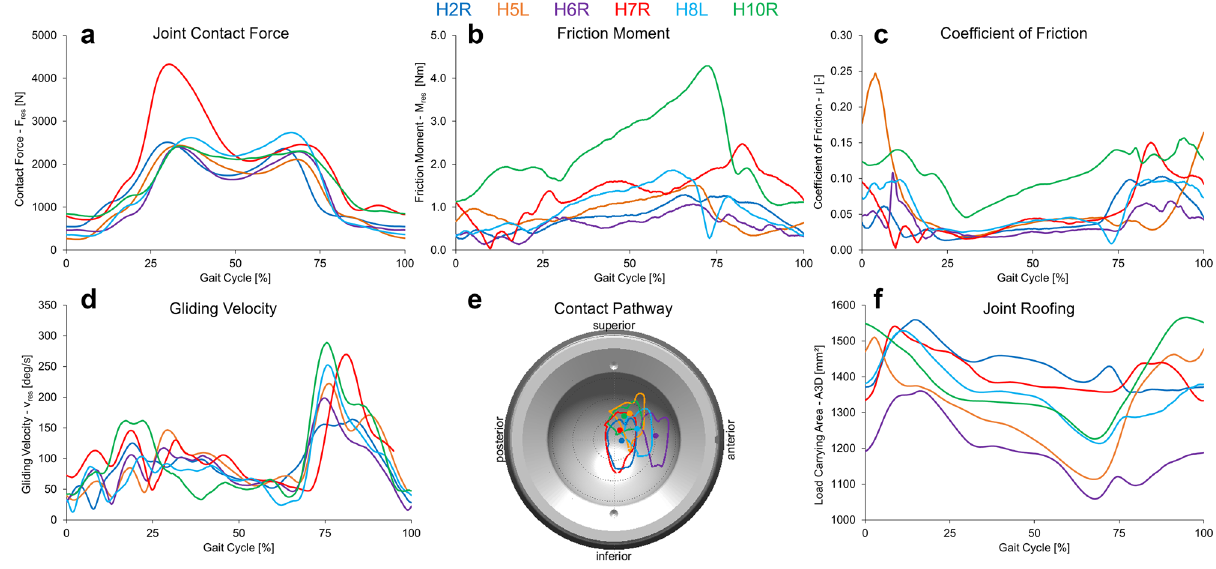
Figure 3. Individual pattern of the in vivo measured joint contact force F res ( a ) and friction moment M res ( b ) in the joint and the resultant coefficient of friction µ res ( c ) the gliding velocity v res ( d ), the contact pathway at the cup surface ( e ) and the resultant joint roofing A3D ( f